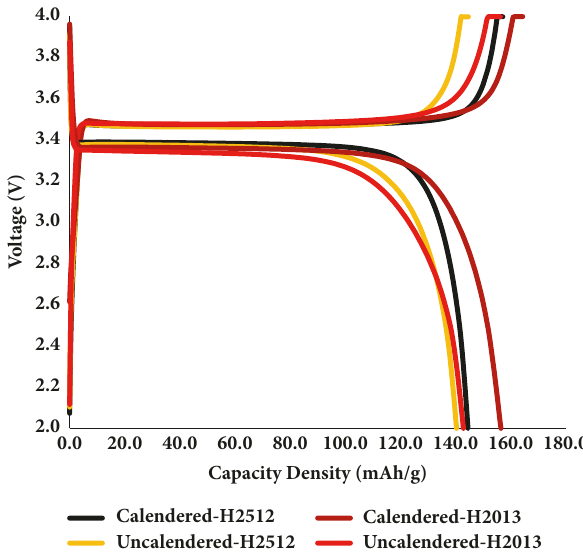
Figure 4: Charge and discharge performance of LFP batteries assembled with trilayer separators H2512 and